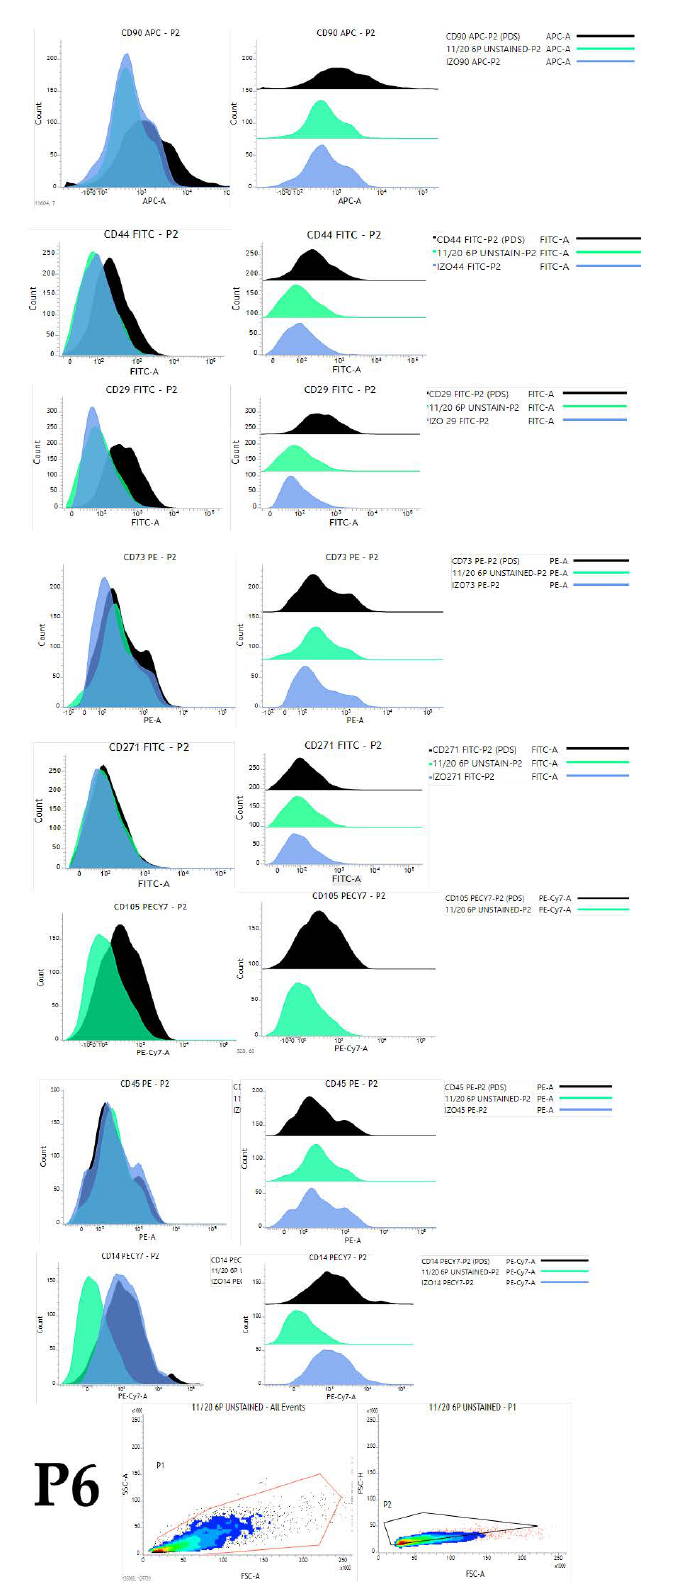
Figure 7. Histogram representation of immunophenotyping results obtained by flow cytometry analysis of cells in passage 6 originating from representative young female canine donor. Histogram presents overlayed unstained population (green), appropriate isotype control (blue) and fully stained population of cells